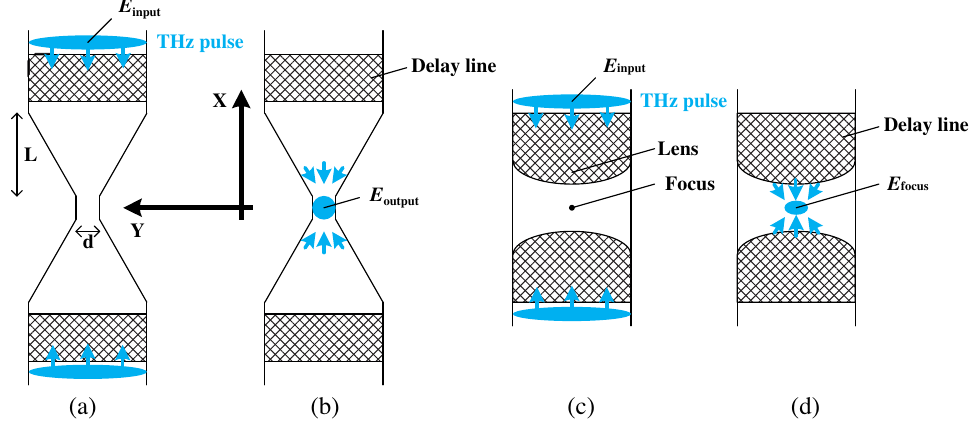
FIG. 3. Transverse focusing by tapering of the waveguide. THz pulse entering waveguide (a) THz pulse focused on the accelerating gap (b). Transverse focusing by a lens. THz pulse entering waveguide (c). THz pulse focused on the accelerating gap